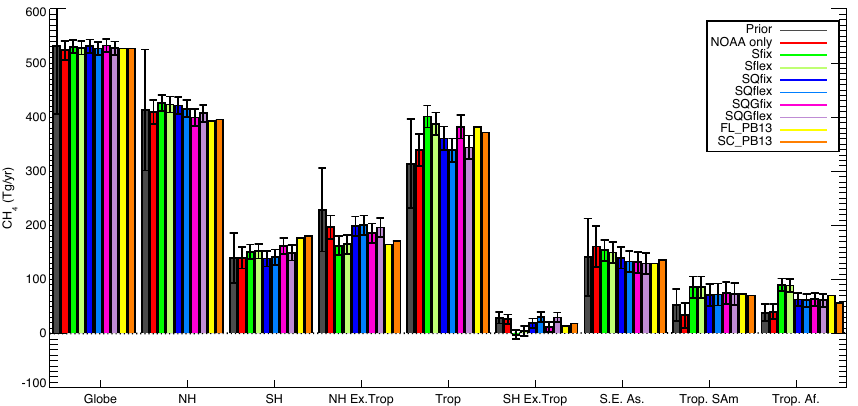
Fig. 14. Comparison of inversion derived fluxes integrated over regions and over the period 2003–2010, including results from the NOAA- only (S1-NOAA) and NOAA + SCIA (S1-SCIA) inversion from Bergamaschi et al. (2013). Error bars represent 2 σ uncertainties. For the region definition see Fig. 1.